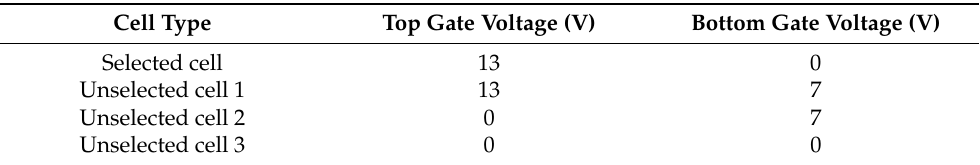
Table 2. The voltage applied in the selected cell and unselected cells during programming with the proposed NOR array design.